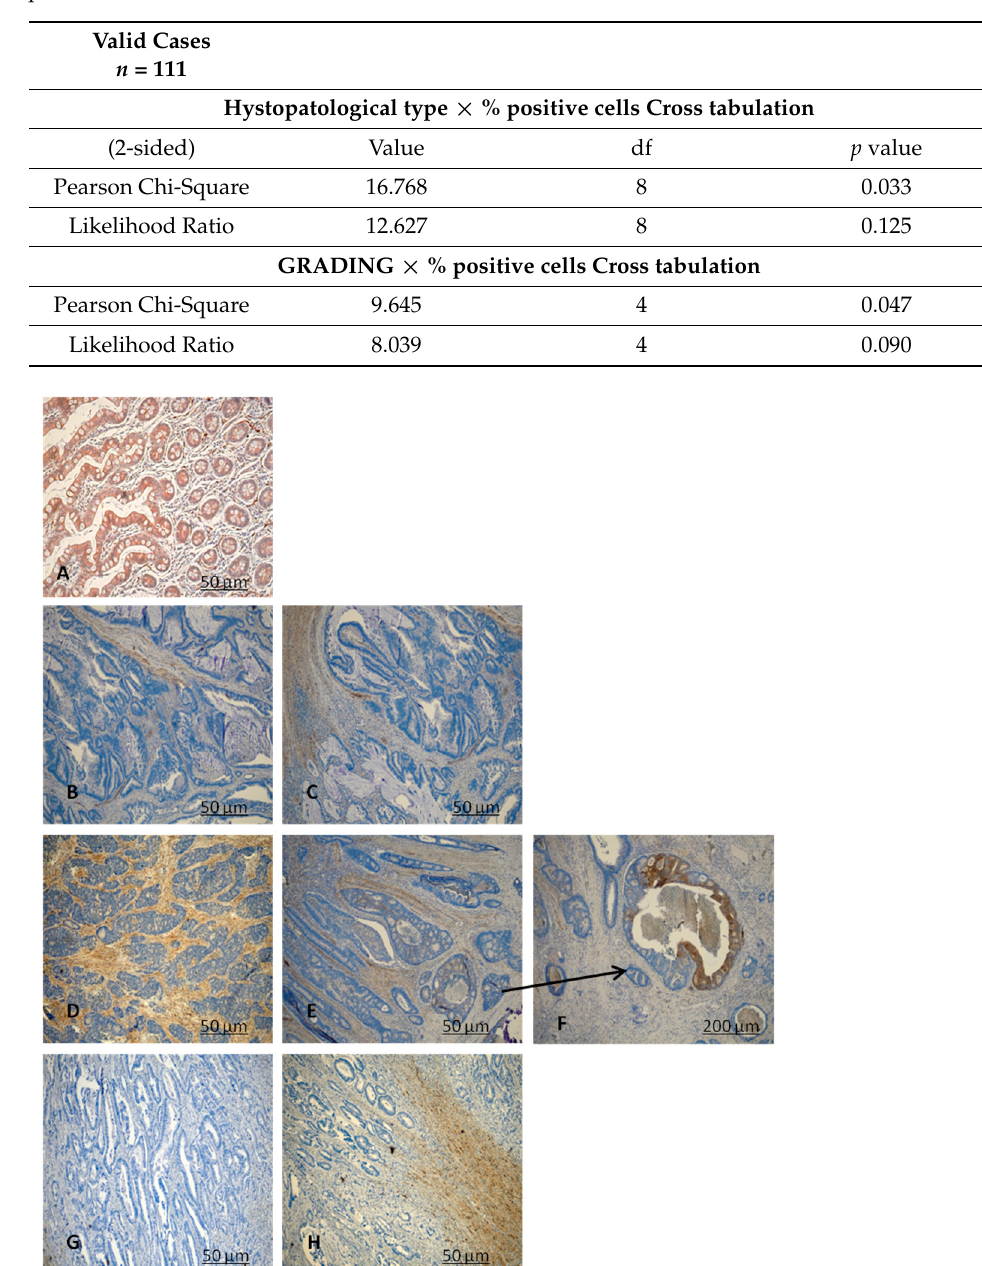
Figure 1. Representative figures of CRYAB protein expression in colorectal cancer (CRC) tissues ( B–H ) and non-cancerous tissues ( A ) by immunohistochemistry (IHC) analysis. ( A ) High expres- sion of CRYAB in non-cancerous cells. ( B , C ) (well differentiated) low expression in the neoplastic glandular structures; ( D – F ) (moderately differentiated) high expression of CRYAB in neoplastic cells ; ( G , H ) (poorly differentiated) negative expression of CRYAB in CRC cells. ( A – E,G,H ) 10×; ( F ) 40× magnification.